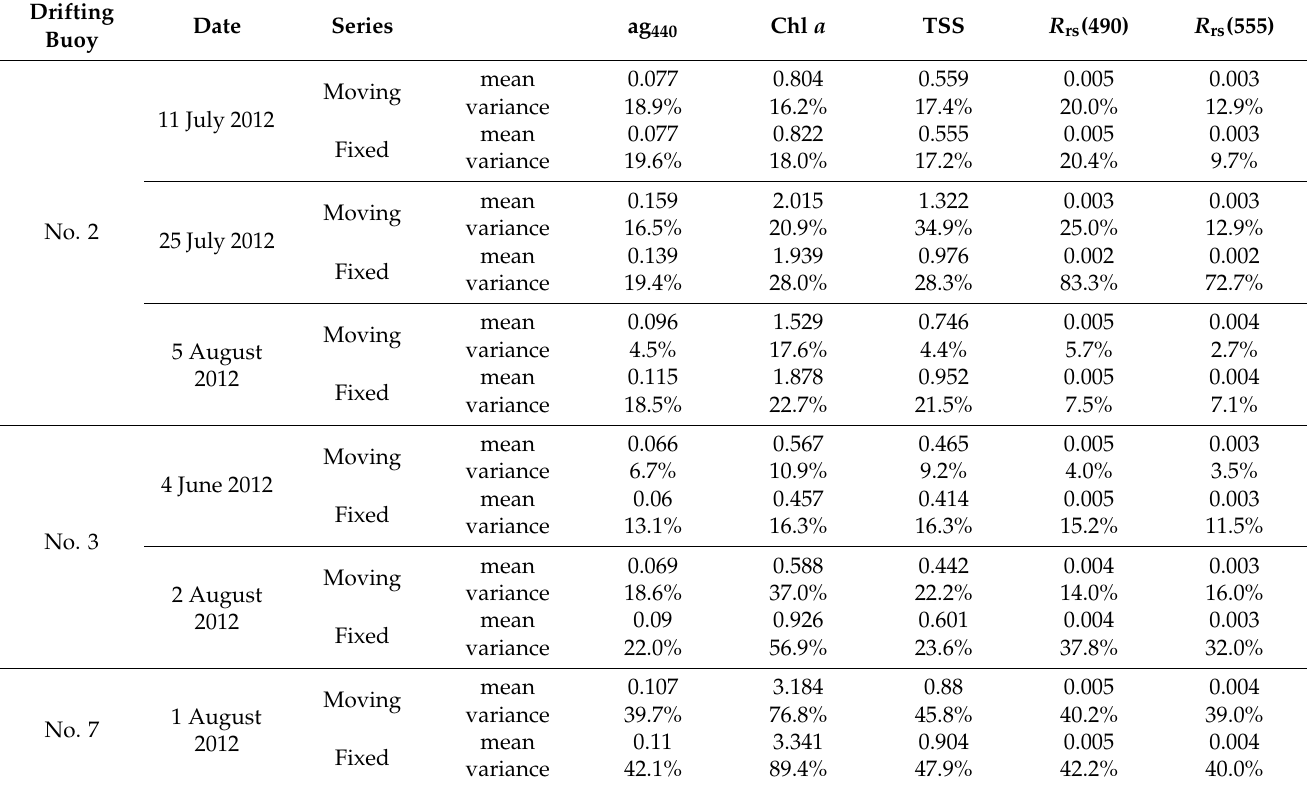
Table 3. Statistics of bio-optical properties on six matched days.